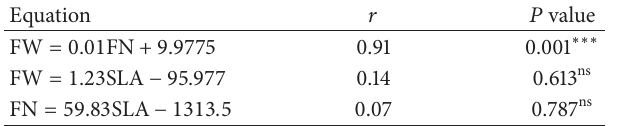
Table 2: Correlation coefficient ( 𝑟 value) among fruit number (FN), fruit weight (FW), and specific leaf area (SLA) of T. daniellii foliage harvested over 64